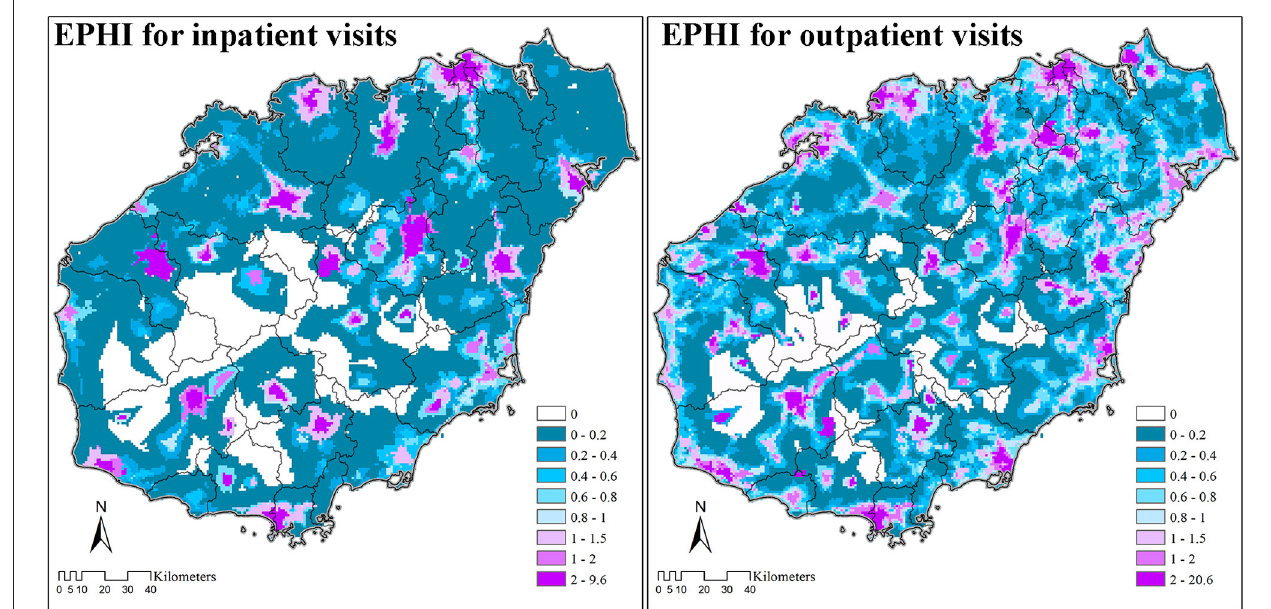
FIGURE 3 | External Patient Healthcare Index (EPHI) of inpatient and outpatient visits on Hainan Island (2018).